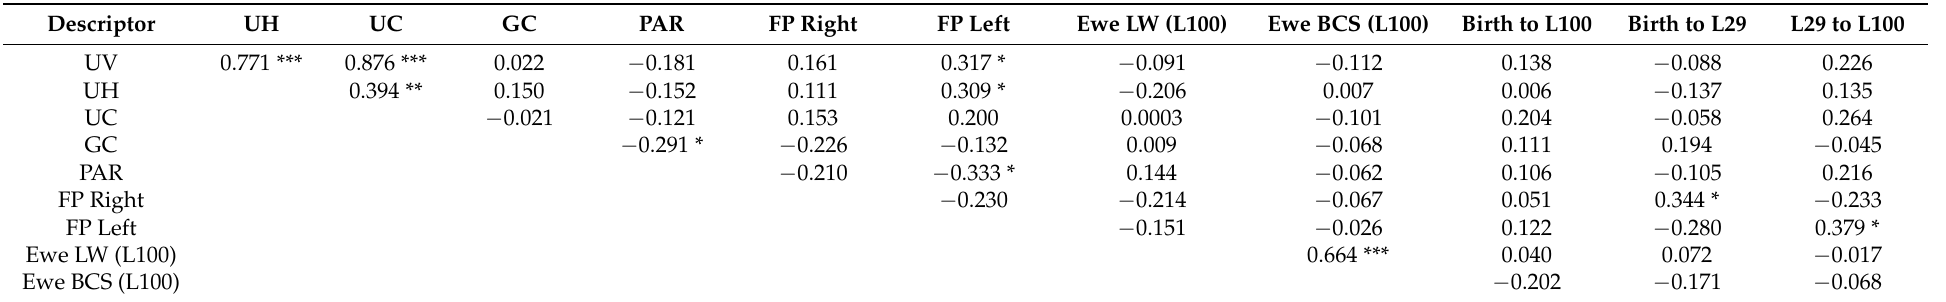
Table 6. Correlation coefficients of residuals of udder volume (UV), circumference (UC), height (UH), gland cistern (GC), parenchyma (PAR) and fat pad from the right (FP Right) and left (FP Left) udder halves at L100, body condition score and live-weight of yearling ewes (Ewe BCS and Ewe LW) at weaning (L100) 1 , lamb growth from birth to weaning (Birth to L100), birth to early lactation (Birth to L29) and early lactation to weaning (L29 to